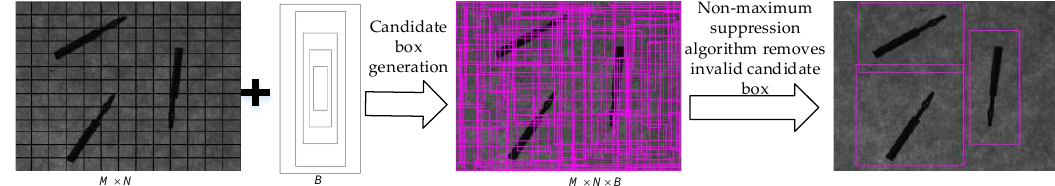
Figure 3. Removal of invalid candidate boxes using the non-maximum suppression algorithm.